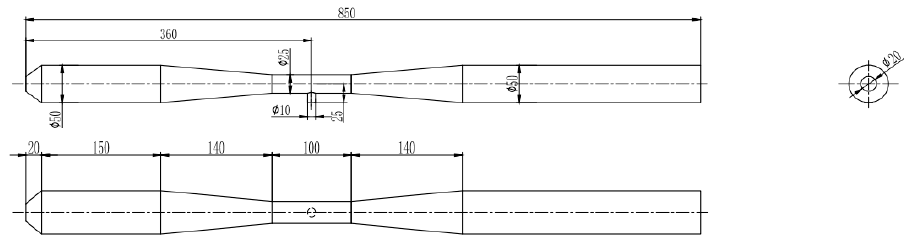
Figure 1. Dimensions of the jet-flow pyrolysis reactor (unit: mm).